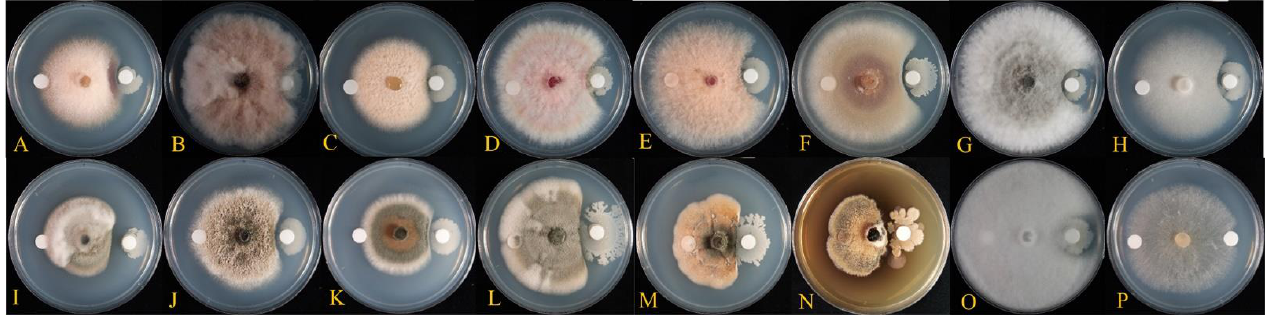
Figure 3. Antifungal activity of test strains against the indicator strains. Inhibition effect of mycelial growth of Fusarium fujikuroi KACC 44002 ( A ), F. graminearum KACC 41040 ( B ), F. graminearum